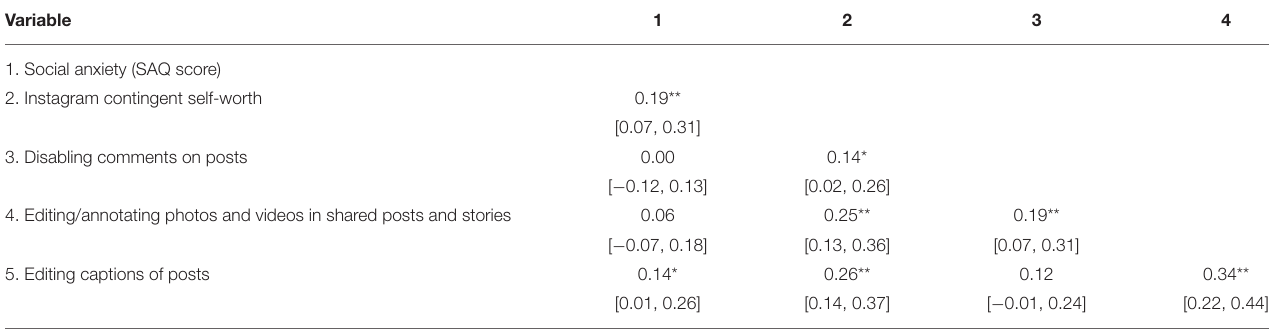
TABLE 1 | Pairwise correlations between all measures of interest. Variable